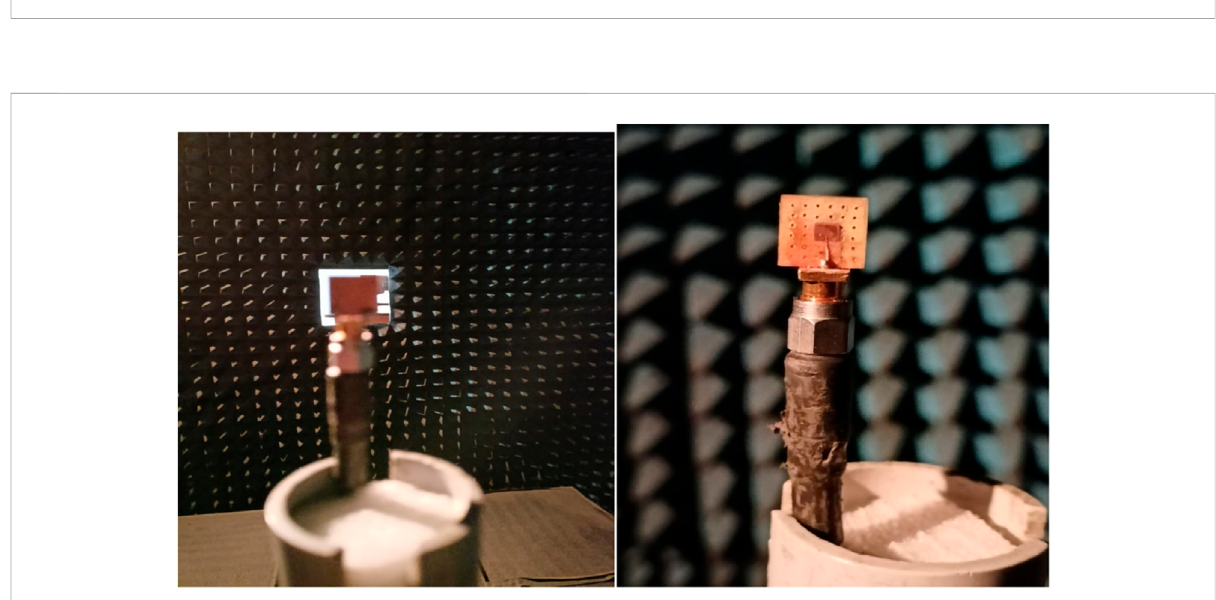
FIGURE 10 Electrical Characterization of fabricated antenna in Anechoic